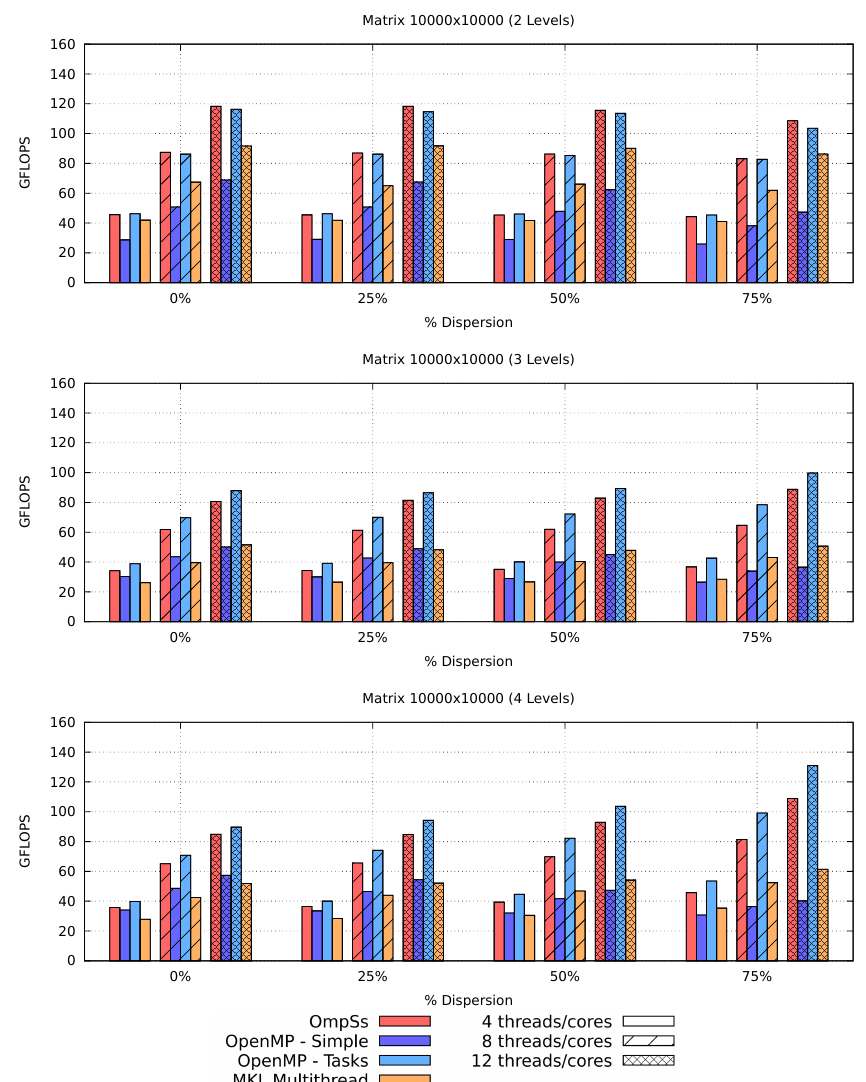
Fig. 6 Performance of the task-parallel H -Cholesky factorization of a matrix of order 10,000 using OpenMP and OmpSs in the Intel E5-2603v3 server using 4, 8 and 12